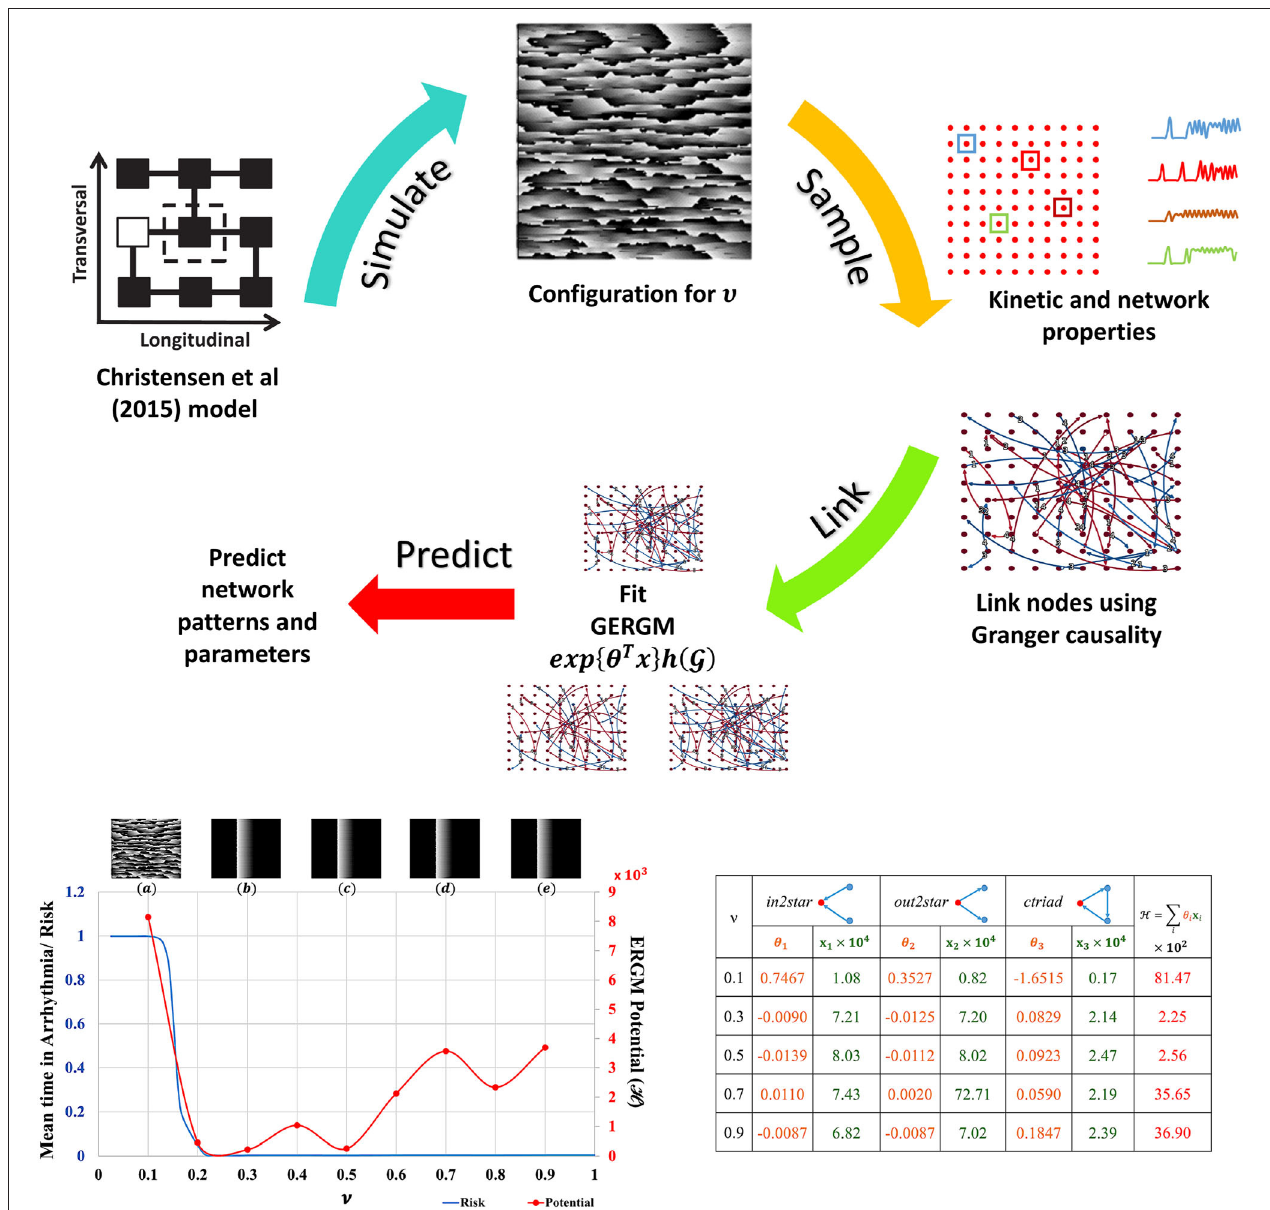
FIGURE 2 | ERGM evaluation. Top : Schematic of ERGM generation process. State-transition kinetics for 2D tissue characterized by ν is sampled (red dots), the transition kinetics (a color coded subset along with their locations on the 2D tissue is shown) is used to create the causal network. Other nodal and network observations are also collected. A GERGM model is fit to the causal network to predict networks with similar topological characteristics, nodal and network observations. Bottom Left : Model predicted “Mean time in arrhythmia/Risk of arrhythmia” as a function of lateral uncoupling parameter ν . Insets show the plane wave dynamics exhibited by the model at T = 1,000 units for each ν . Each 2D model consists of 200 × 200 cells with a refractory period of 50 ± 5 units, and 20 randomly placed dysfunctional cells that misfire with a probability of 0.05. Pacemaker cells at the left edge self-activate with a period of T = 220 units and initiate a planar wave. As ν decreases from 1.0, a transition from planar wave fronts to a system of multiple self-sustaining reentrant circuits ( ν ≤ 0.14) is observed. The corresponding ERGM potentials are plotted along with the inset label. Bottom Right: GERGM calculated coefficients ( θ i ) for the observed network structural characteristics ( x i ) and the calculated potential. See Supplementary Material for full images and method